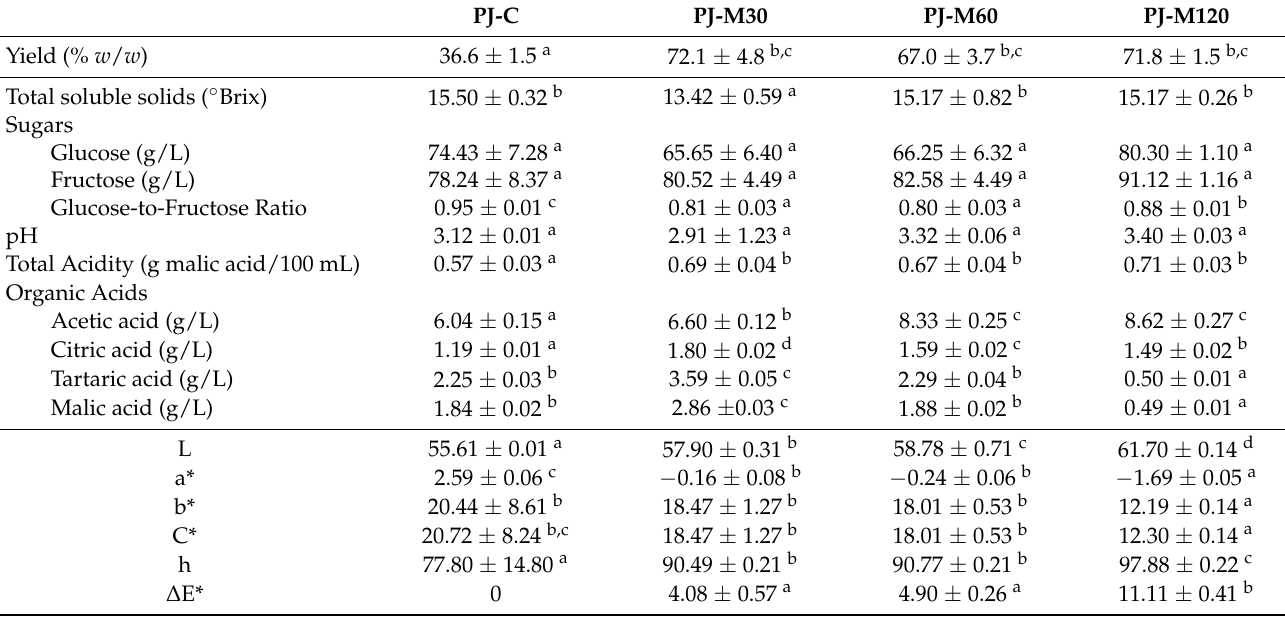
Table 1. Yield and physicochemical parameters of persimmon juice produced without (PJ-C) and after persimmon pulp treatment at different microwave heating conditions (PJ-M30, PJ-M60,